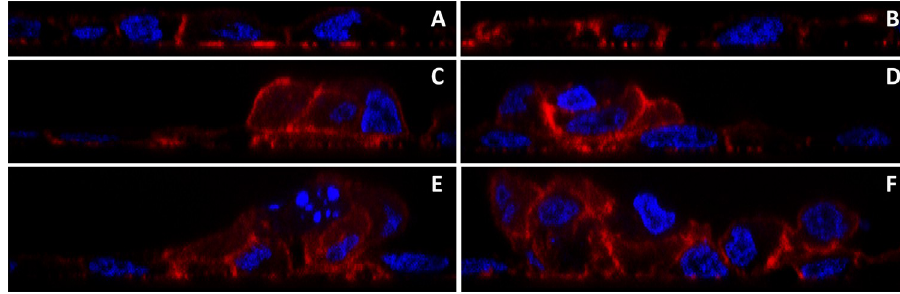
Fig 5. Orthogonal images of F-actin localization. F-actin (red) and nuclei (blue) are seen in orthogonal sections along the x-axis (A, C and E) and y-axis (B, D and F) for same 3 fields shown in Fig 4. The non-doming monolayer (A and B), the moderately tall dome (C and D) and the taller dome structure (E and F) are all shown.